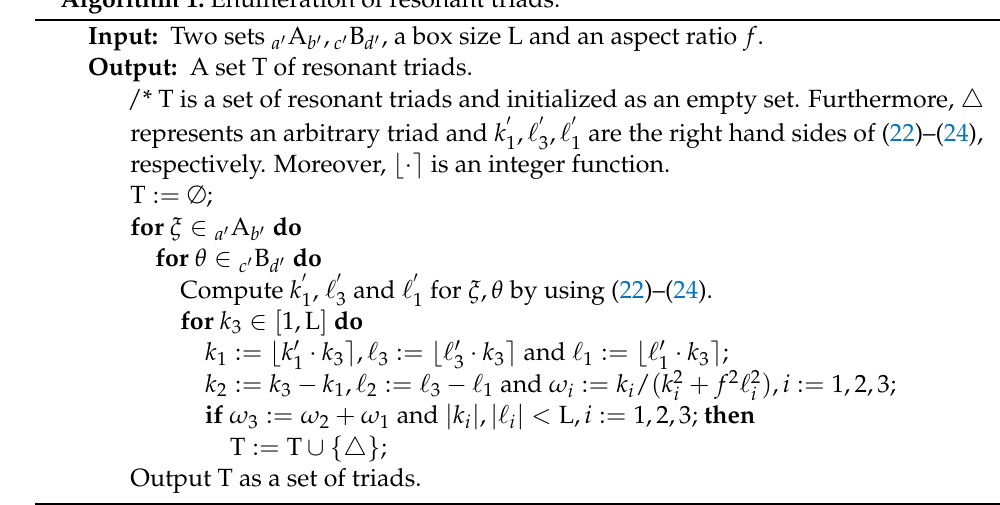
Algorithm 1: Enumeration of resonant